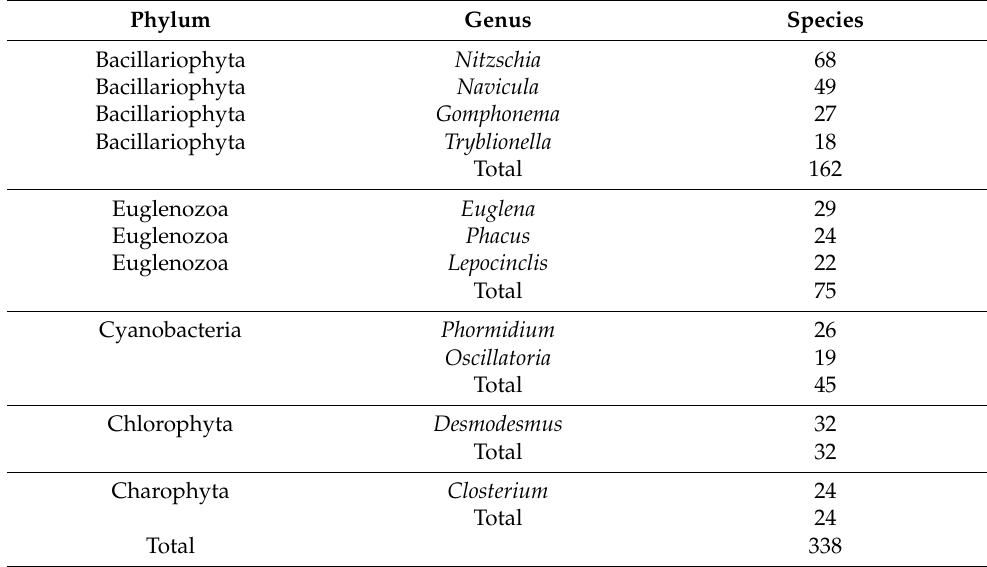
Table 2. Most species rich genera of algae and cyanobacteria flora in aquatic habitats of